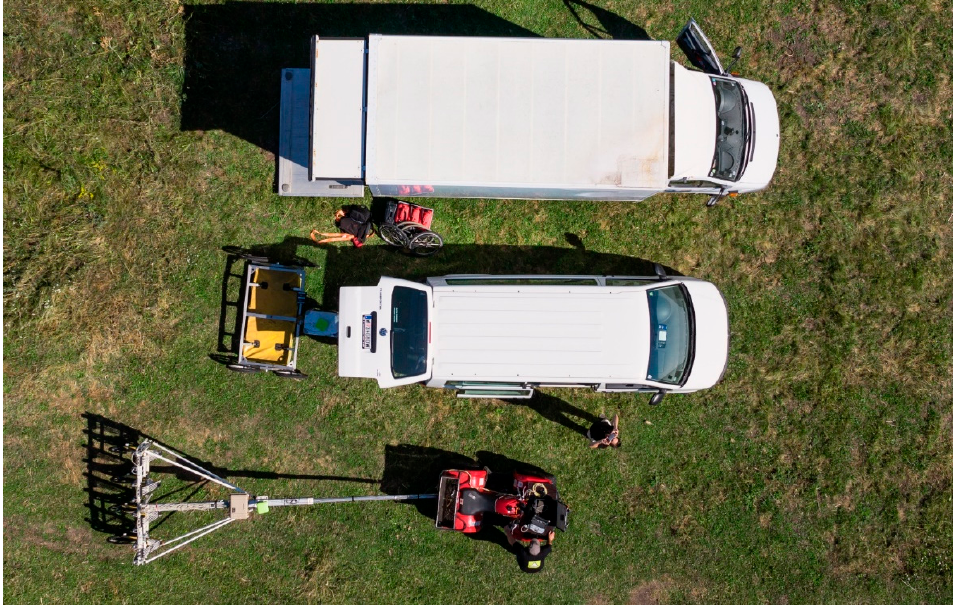
Figure 5. Aerial photograph of the 6-channel SPIDAR GPR system (center) and the magnetometer system (bottom) with their corresponding towing vehicles on site, photographed from the UAS. Photo: Geert Verhoeven.